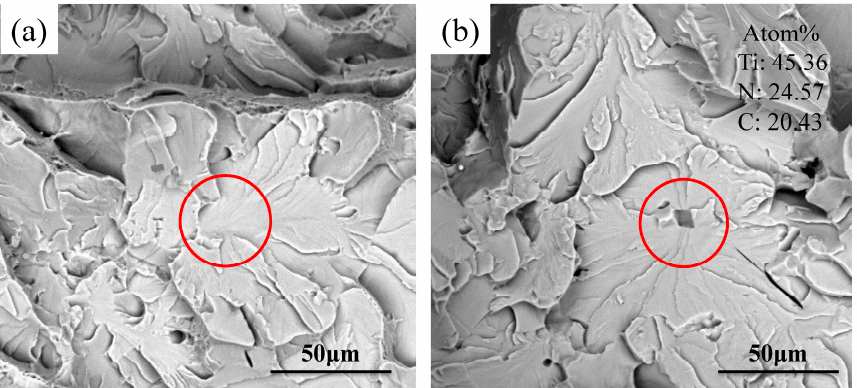
Figure 4. SEM images at initiation sites for brittle fractured sample steel 1-890; ( a ) nothing; ( b ) coarse Ti(C, N) particle.